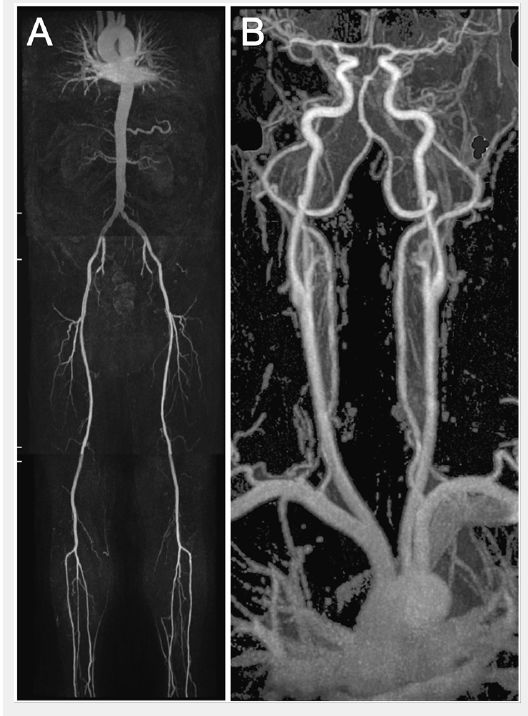
renal-, pelvis/thigh-, knee/calf-stations (A). The second part included the thoracic/carotid-station